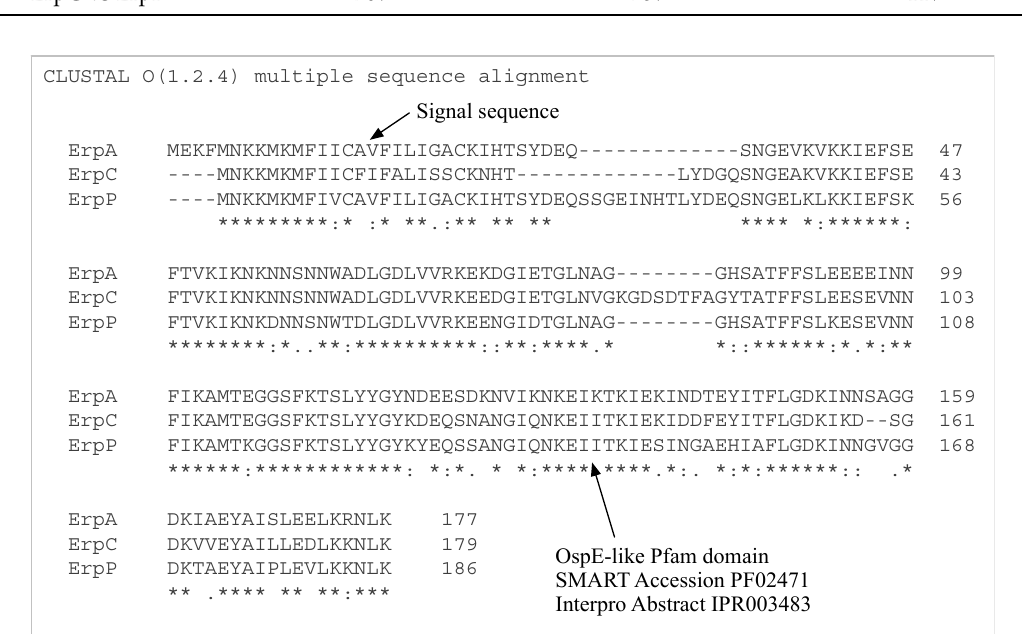
Figure 10. OspE-related (Erp) CRASP Protein Alignment—Clustal Omega (version 1.2.4) alignment for OspE-related (Erp) CRASP proteins shown in Table 2. The region highlighted in green is a shared